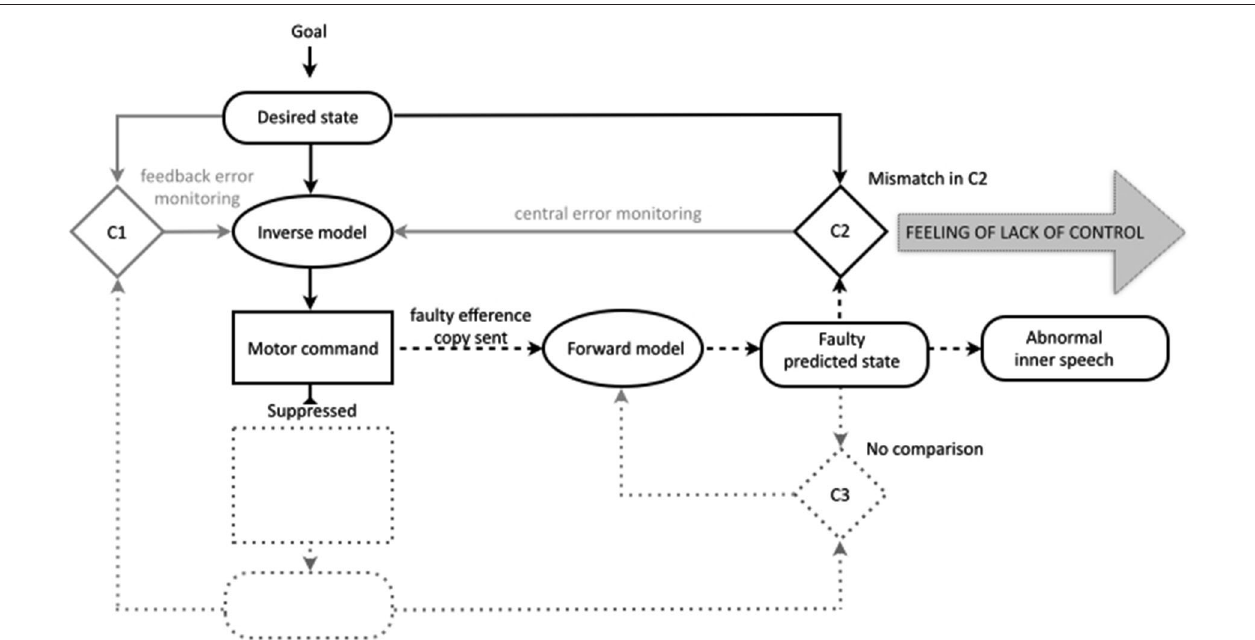
dotted). In ordinary inner speech the match in comparator two between the predicted and desired states gives rise to a feeling of control. In schizophrenia, failures in the predicted state directly affect the conscious experience of the resultant inner speech (abnormal inner speech) and lead to a mismatch in the second comparator, leading to abnormalities in the feeling of intentional